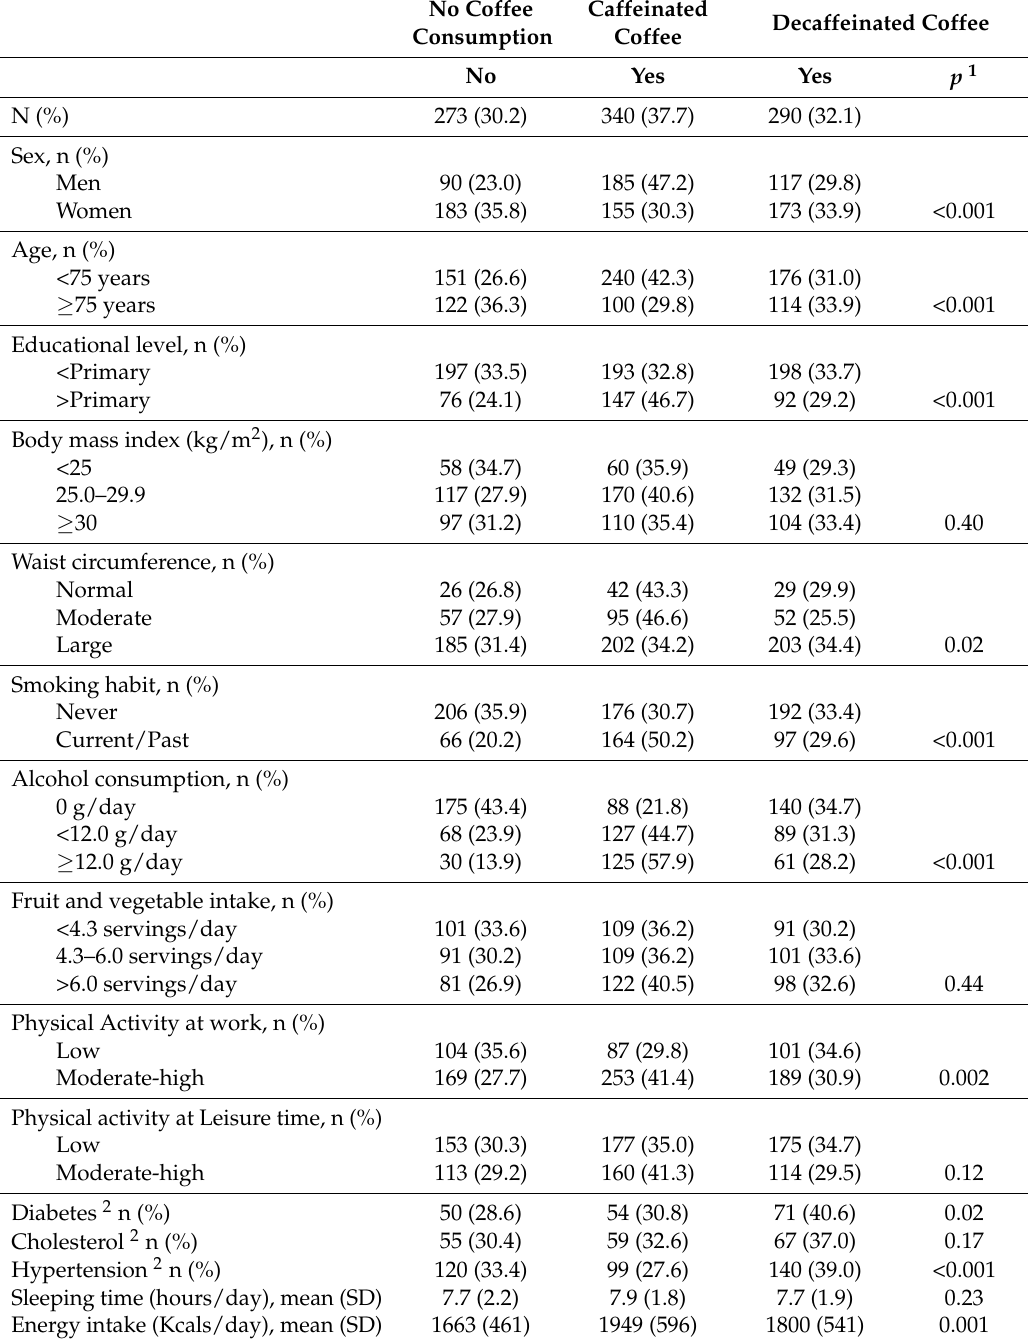
Table 1. Baseline characteristics of the 903 participants, aged 65 years and above, from the EUREYE-Spain Study and the Valencia Nutrition Survey in Spain, according to the type of coffee